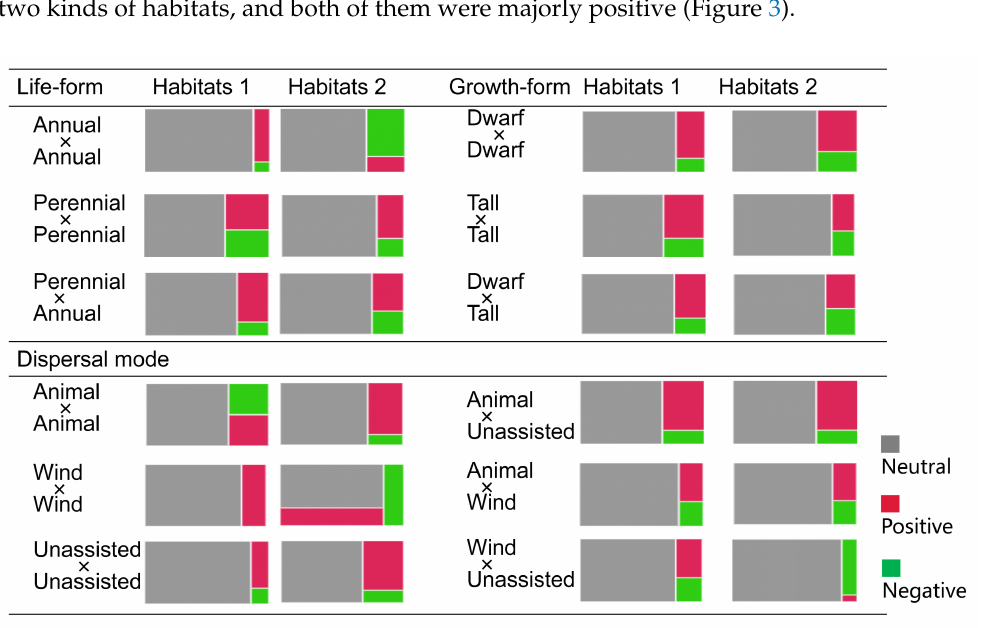
Figure 3. Proportions of neutrally and significantly positively or negatively associated species pairs with each functional trait combination type. The area of a block represents the proportion of species pairs that were neutrally and significantly positively or negatively associated. There was only one liana species in the top 25 species, so the species pairs involving liana species were